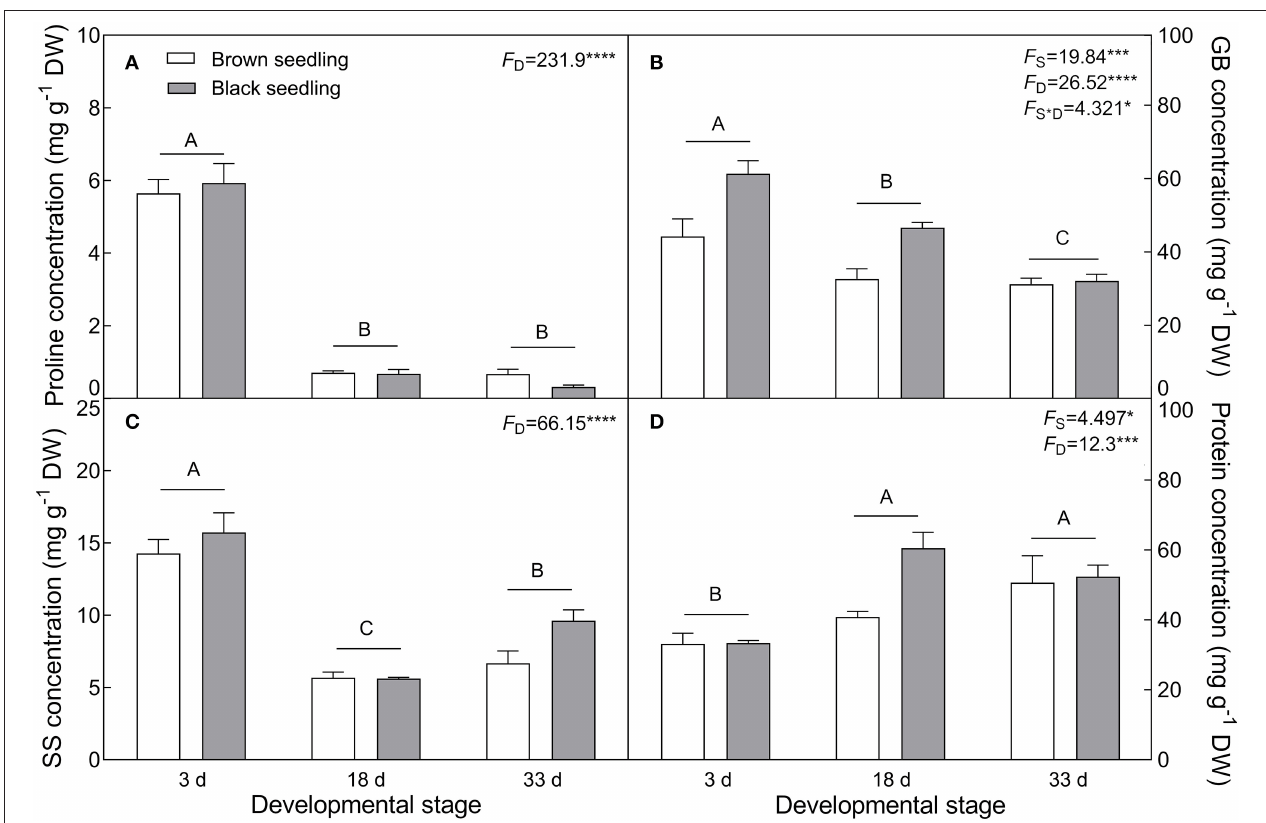
FIGURE 5 | Changes in the concentration of osmotic protectants during seedling development. (A) Proline, (B) glycinbetaine (GB), (C) soluble sugar (SS), and (D) total soluble protein. 3 d, 18 d, and 33 d: represent 3, 18, and 33 days after seedling emergence, respectively. F -values are given when significance levels are reached (the subscript “D” represents “development”; “S”, “seed type”; * P < 0.05, *** P < 0.001; **** P < 0.0001). Bars with different uppercase letters indicate significant differences ( P < 0.05) according to Tukey’s test. Values are means ± SE of four